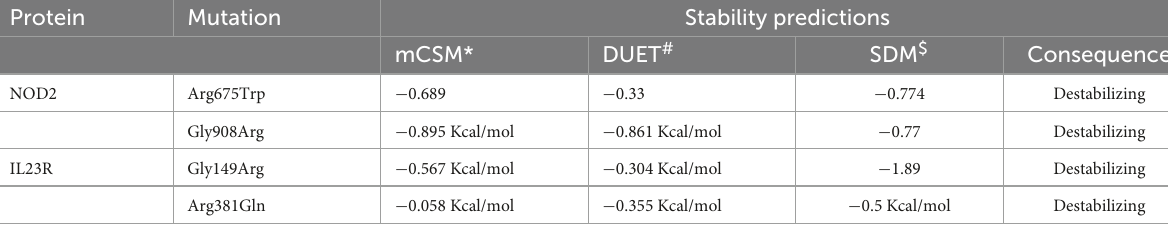
TABLE 3 Protein stability predictions for mutated and wild models of IL23R and NOD2. Protein Mutation Stability predictions mCSM* DUET # SDM $